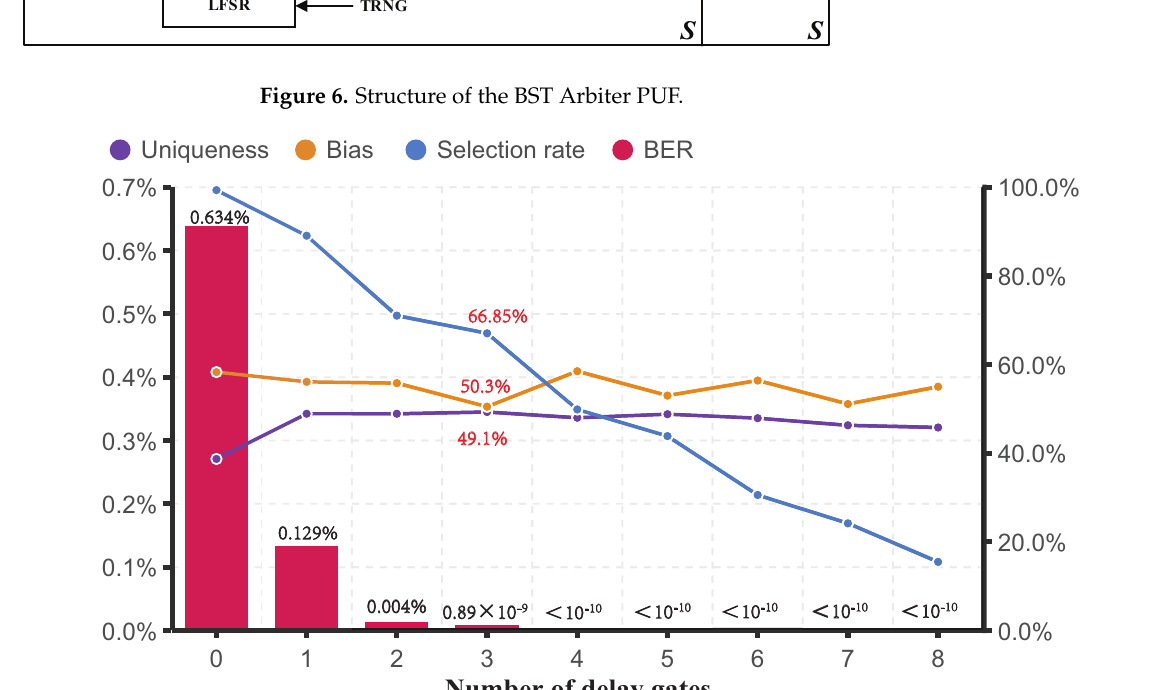
Figure 7. Performance test results of BST-APUF with different numbers of delay